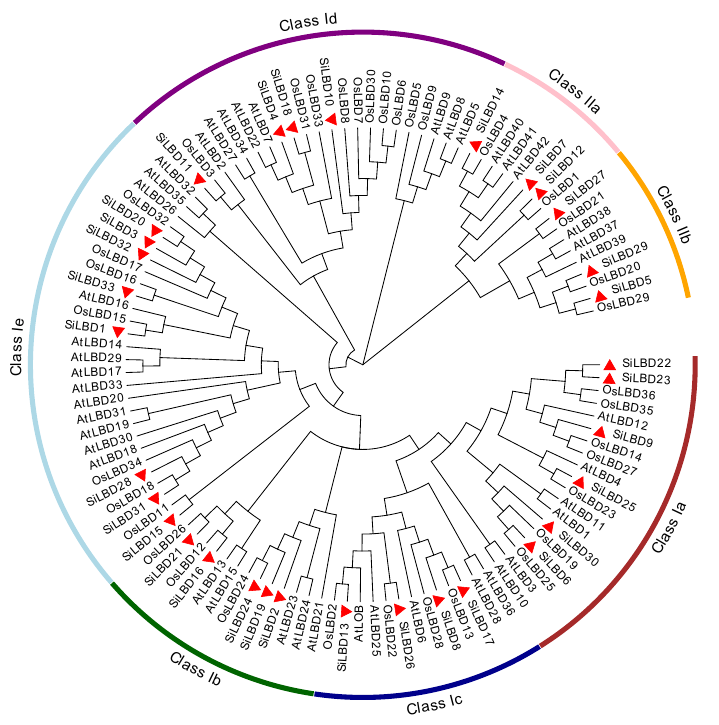
Figure 2. Phylogenetic tree of Arabidopsis thaliana (At), Oryza sativa (Os), and Setaria italica (Si) LBD proteins. SiLBDs are shown by red triangles.